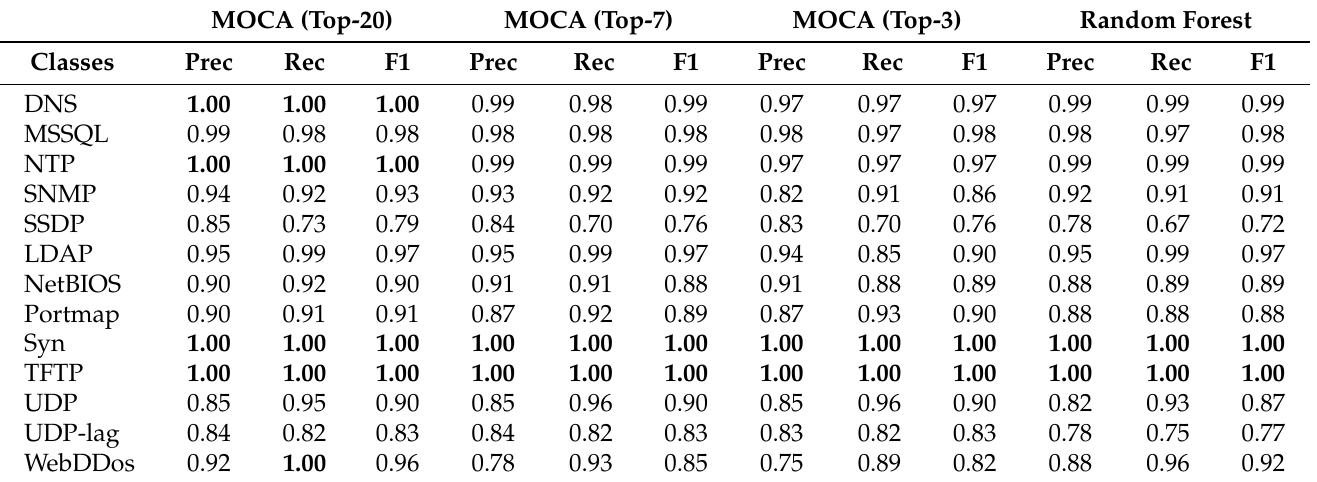
Table 3. Comparison of results for detection accuracy of MOCA vs. Random Forest model based on CICDDoS2019 dataset. MOCA (Top-20) MOCA (Top-7) MOCA (Top-3) Random